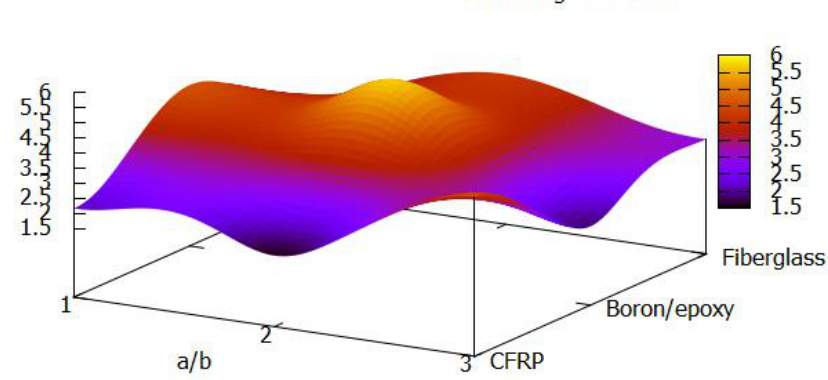
Figure 6. Percentage di ff erence between the buckling loads of the optimised plates and the plates with the stacking sequence from [28].